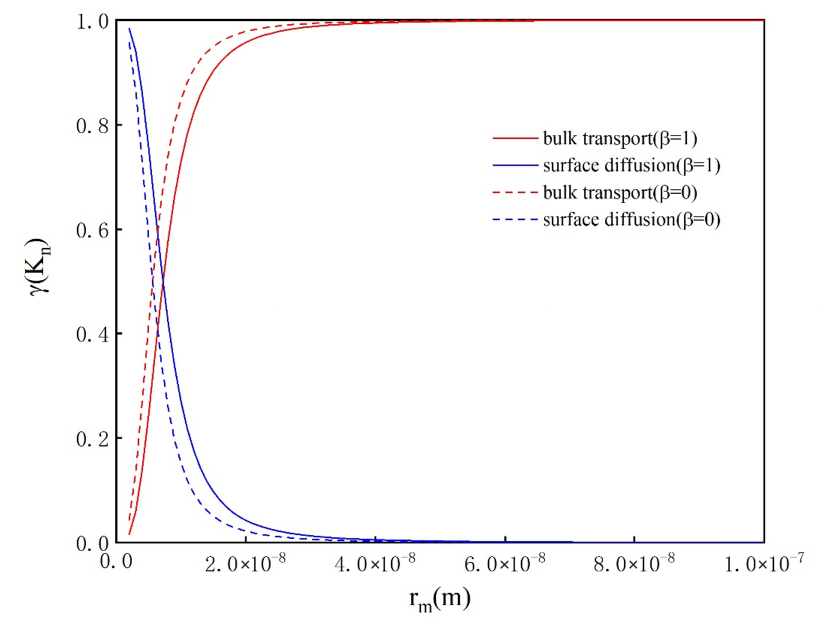
Figure 7. Under different degrees of water molecular coverage, considering K n mechanism vs. pore radius (P = 10 MPa).